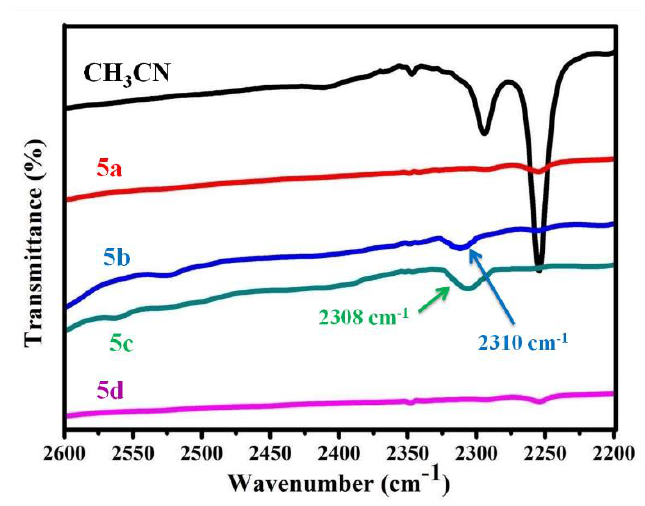
Figure 7. FTIR spectra of pure acetonitrile and B-L MIL + acetonitrile mixtures.